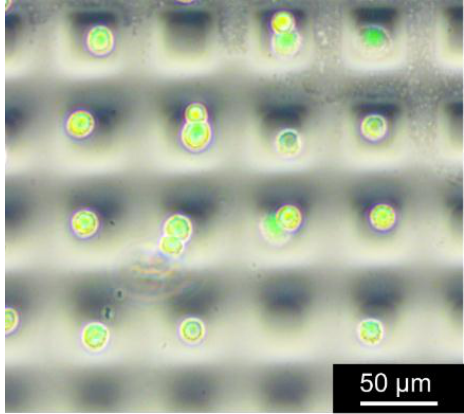
Figure 10. 3T3 cells trapped in a 35 µ m square microwell array chip.